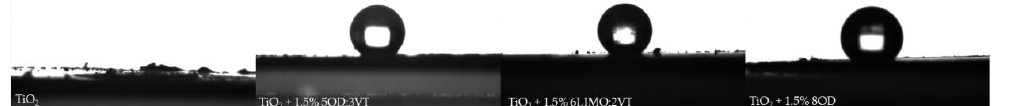
Figure 5. Images of water droplets during sessile drop analysis. Table 5. Water contact angle of TiO 2 [°].